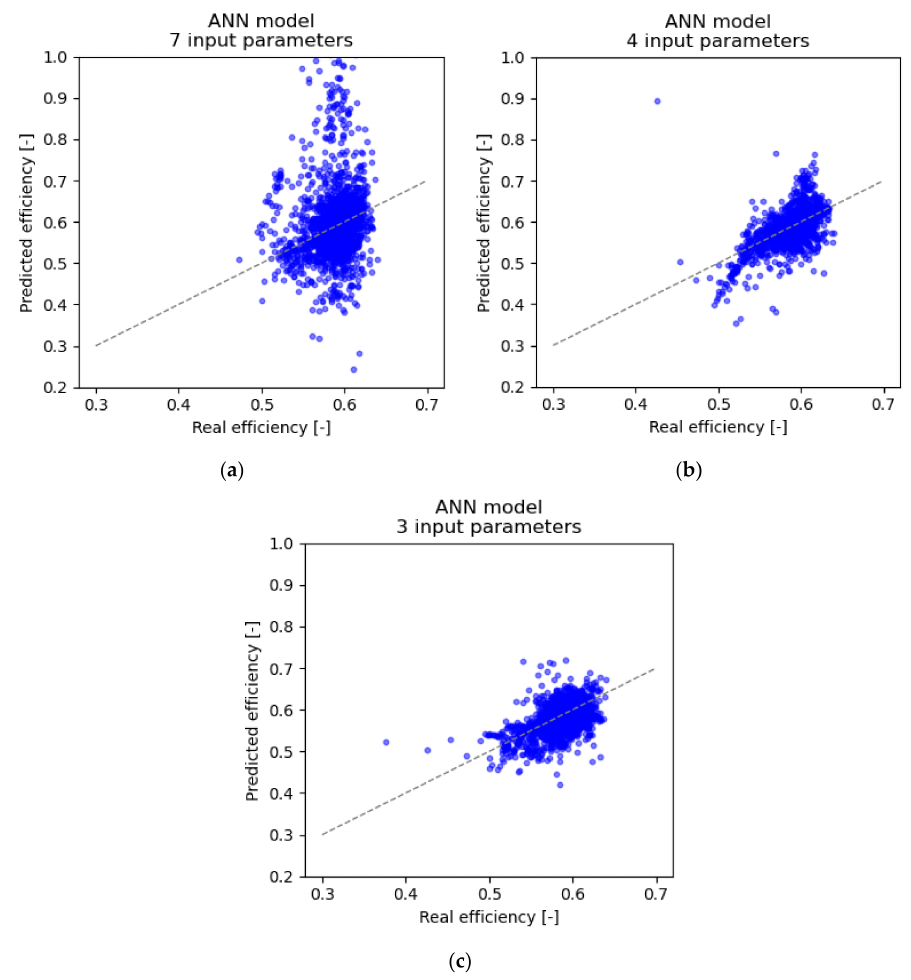
Figure 10. Predicted values as a function of actual values for 3 artificial neural network models with a decreasing number of input parameters: ( a ) 7 inputs parameters, ( b ) 4 inputs parameters, ( c ) 3 inputs